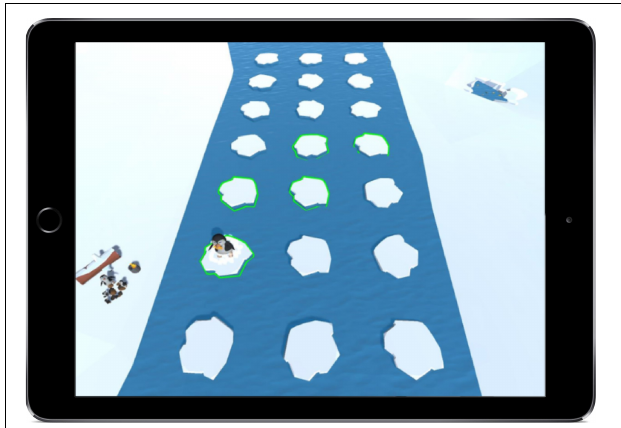
FIGURE 2 | The eFun working memory game (Ice Steps) showing how Pongo the penguin crosses the river to feed the hungry